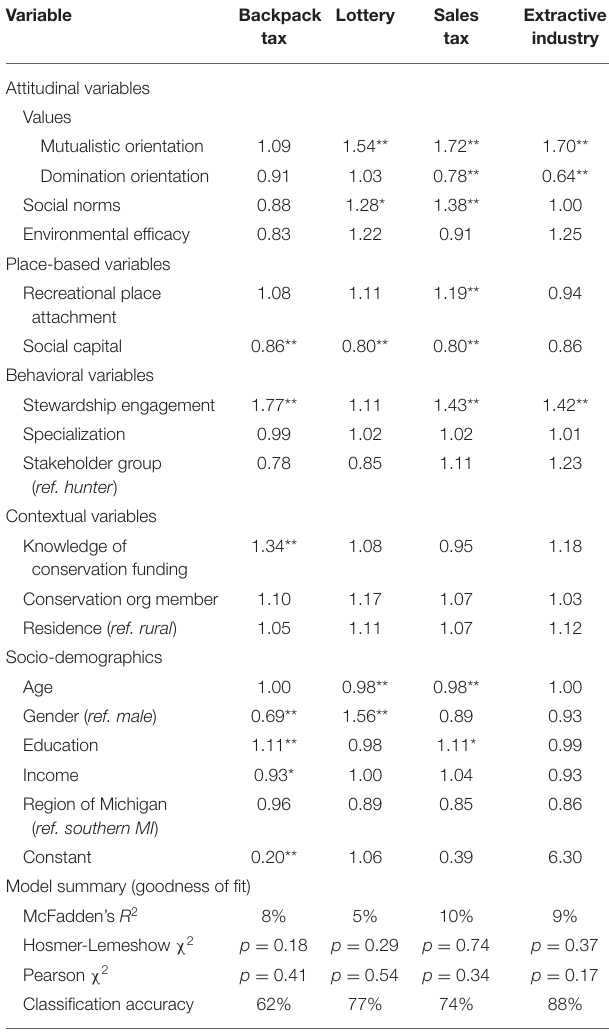
TABLE 2 | Binary logistic regression results ( β coefficients presented as odds